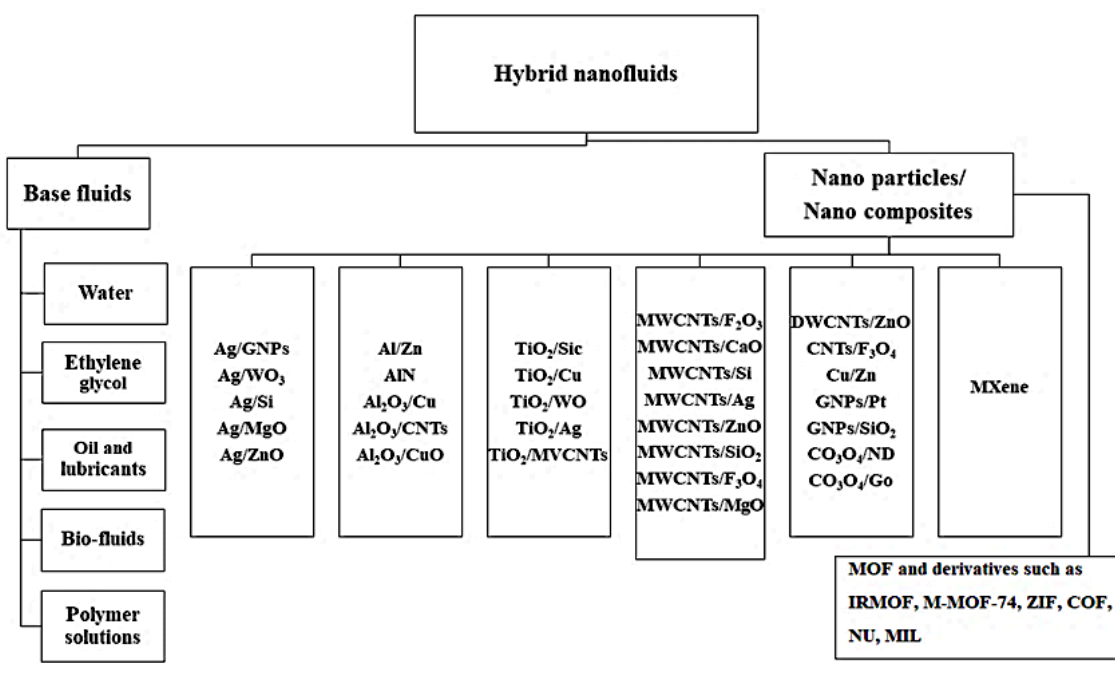
Figure 2. Scenario of different fluids and nanoparticles used for preparing hybrid nanofluids.